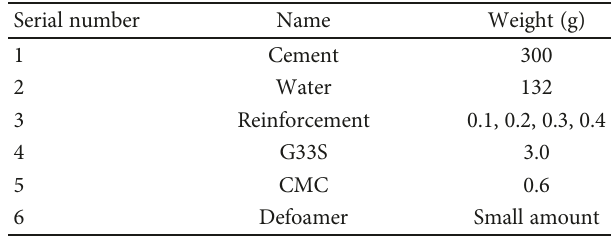
Table 4: Cement slurry formula.